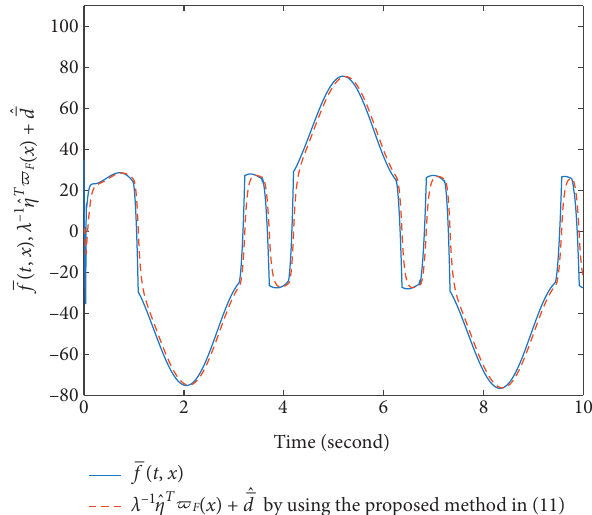
Figure 4: Trajectory of u by using the method in (27).